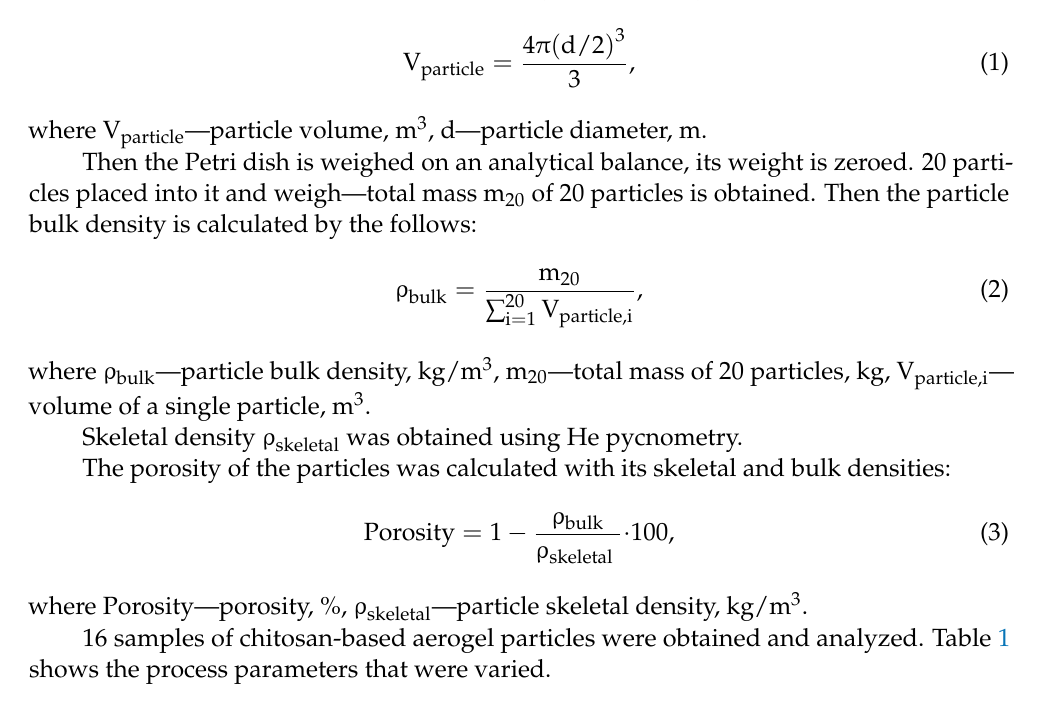
Table 1. Variable parameters in the preparation of chitosan aerogel